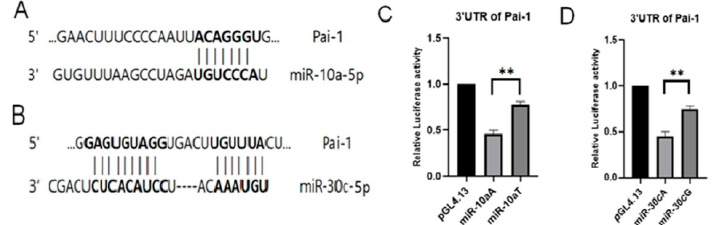
Figure 1. Expression of miR-10a A>T, miR-30c A>G, and the regulation of 3 ′ -UTR of PAI-1 by miR-10a and miR-30c . ( A , B ) A schematic representation of gene with 3 ′ -UTR of PAI-1 that contain possible miR-10a and miR-30c binding sites in conserved regions. ( C ) Dual-luciferase reporter assays were performed to test the interaction of hsa- miR-10a A>T and its targeting sequence in the PAI-1 3 ′ -UTR using constructs containing the predicted targeting sequence (pGL4.13-PAI-1 3 ′ -UTR) cloned into the 3 ′ -UTR of the reporter gene. Luciferase expression levels were normalized against Renilla luciferase expression. Data represent three independent exper-iments with triplicate measurements. ** p < 0.05. ( D ) Dual-luciferase reporter assays were performed to test the interaction of miR-30c A>G and its target sequence in the PAI-1 3 ′ -UTR using constructs containing the predicted targeting sequence (pGL4.13-PAI-1 3 ′ -UTR) cloned into the 3 ′ -UTR of the reporter gene. Luciferase expression levels were normalized against Renilla luciferase expression. Data represent three independent experiments with triplicate measurements. ** p < 0.05.